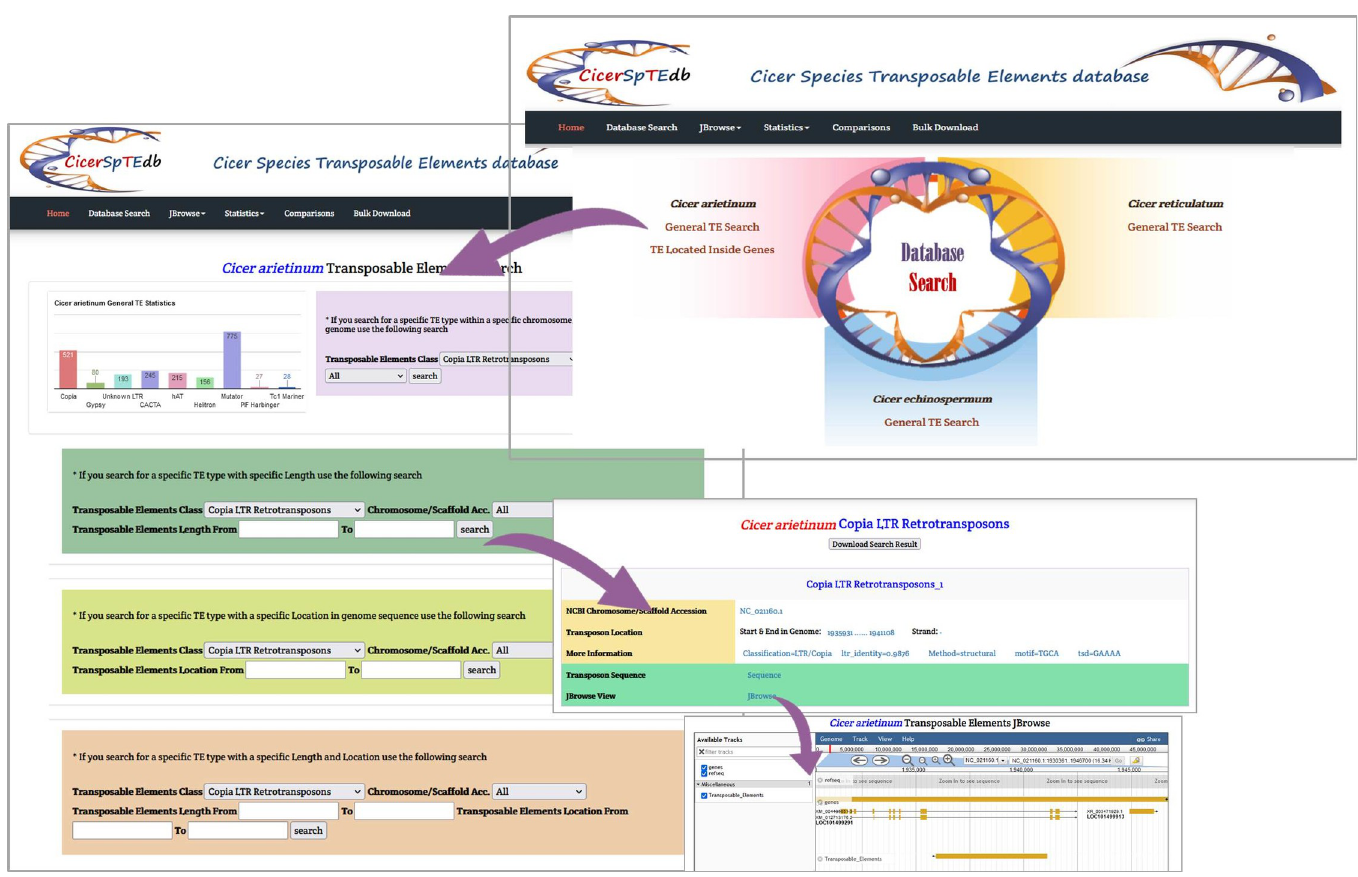
Fig 7. CicerSpTEdb’s TE general search